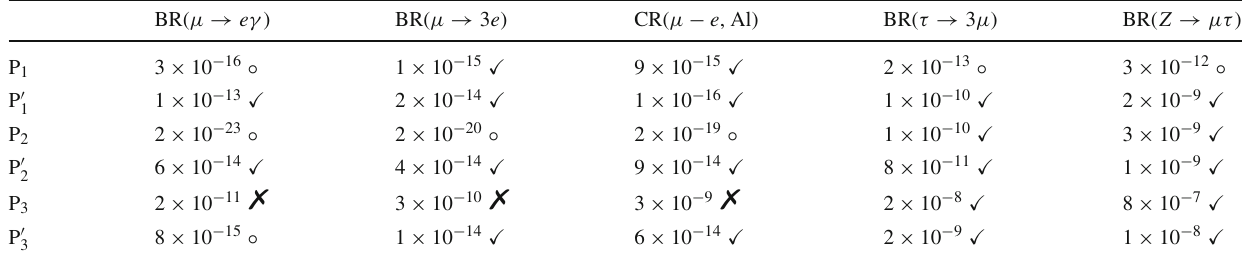
Table2 PredictionsforseveralcLFVobservablesinassociationwiththreeconfigurationswithvanishingCPVphases,P i ( i = 1 − 3)andassociated , see Eqs. (32, 33). We have taken m 4 = m 5 = 5 TeV. The symbols ( (cid:2) , (cid:3) , ◦ ) respectively variants with non-vanishing CP violating phases, P (cid:3) i denote rates already in conflict with current experimental bounds, predictions within future sensitivity and those beyond future experimental